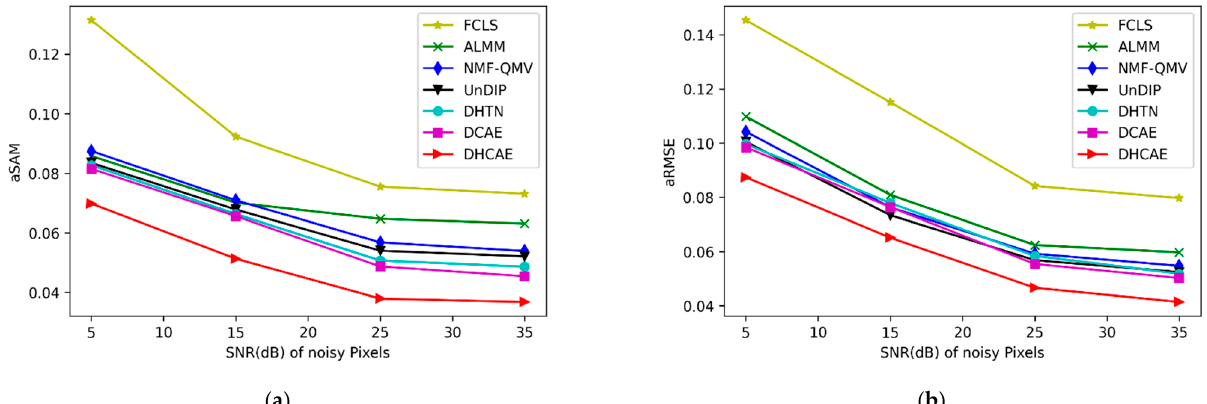
Figure 6. Robustness evaluation of the unmixing methods with various levels of pixel noise. ( a ) aSAM. ( b ) aRMSE.